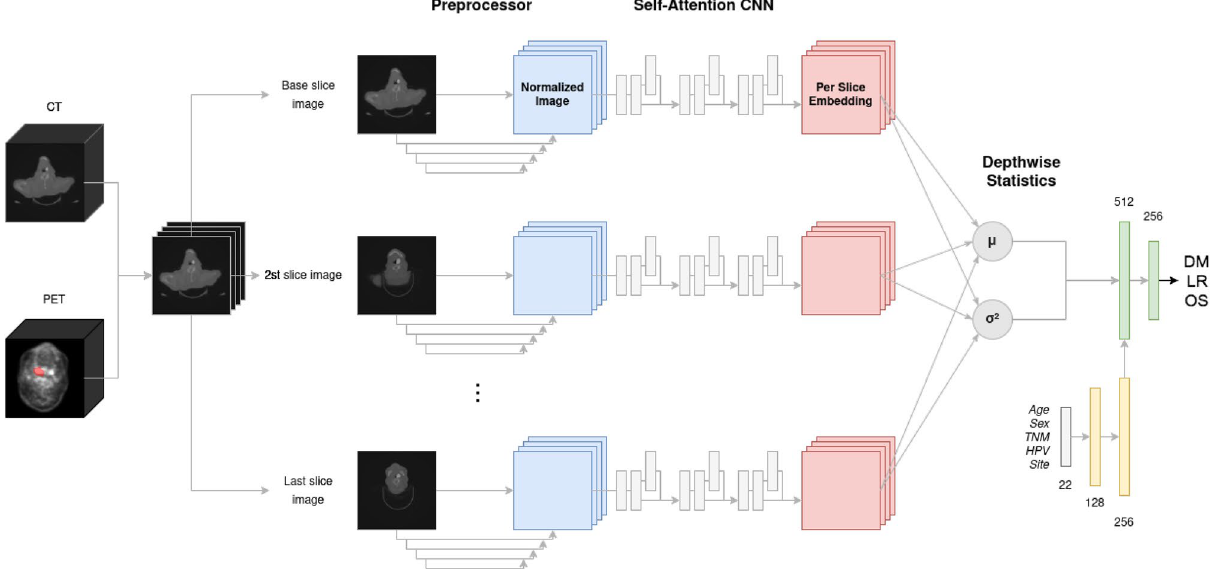
Figure 6. Proposed PreSANet deep learning architecture for radiotherapy outcome prediction. The convolutional backbones consist of the combination of the preprocessor module and the self-attention CNN feature extractor. Using shared weights, each of the two channel (PET, CT) input volume is split into individual slices passed to the backbone. The resulting per-slice feature vectors are aggregated using mean and variance into two 256-feature vectors. They are then concatenated with the outputs of a fully connected network component (yellow) that processes the clinical input data forming a 768 feature vector. Figure created with Draw.io